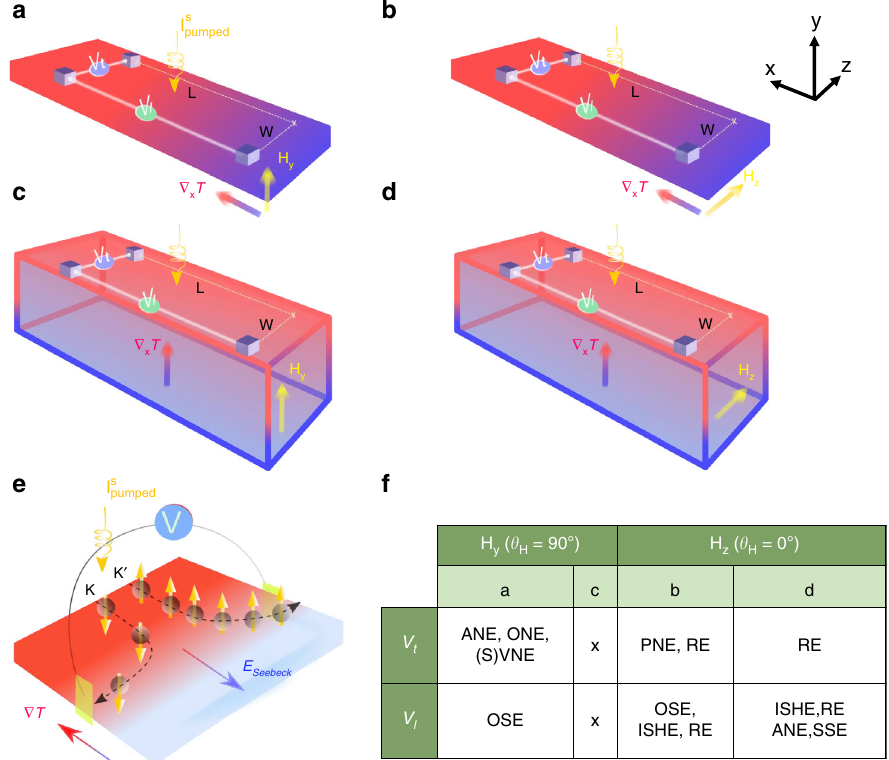
Fig. 2 Schematics of the transverse ( V ), longitudinal ( V ) voltages measured under different con fi gurations and the electrical detection of the VNE. t l The external applied magnetic fi eld ( a , c ) perpendicular and parallel ( b , d ) to the sample surface. The temperature gradient: in-plane for ( a , b ) and out-of- plane for ( c , d ). W and L stand for transverse and longitudinal distances. e Illustration of the VNE with electrical detection in open circuit conditions. f Resume of emerging effects with respect to our experimental set-up in each con fi guration ( a – d ): OSE (all the stack), ISHE (NiFe, WSe 2 ), (S)VNE (WSe 2 ), ANE (NiFe), ONE (all the stack), PNE (NiFe), RE (NiFe) and SSE (NiFe) stand for ordinary Seebeck effect, inverse spin Hall effect, (spin) valley Nernst effect, anomalous Nernst effect, ordinary Nernst effect, planar Nernst effect, recti fi cation effects (due to the anisotropic magnetoresistance and anomalous Hall effect) and spin Seebeck effect,